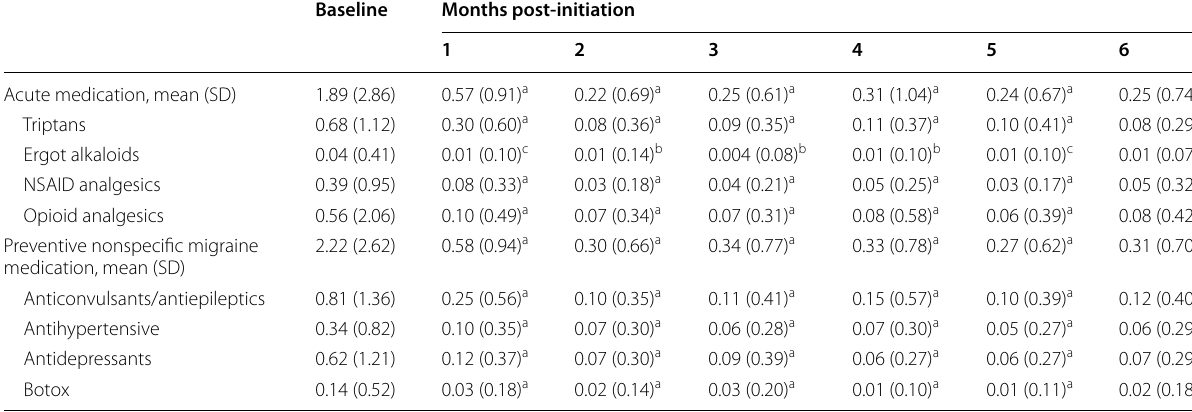
6 months) patients with a defined dose ( n ≥